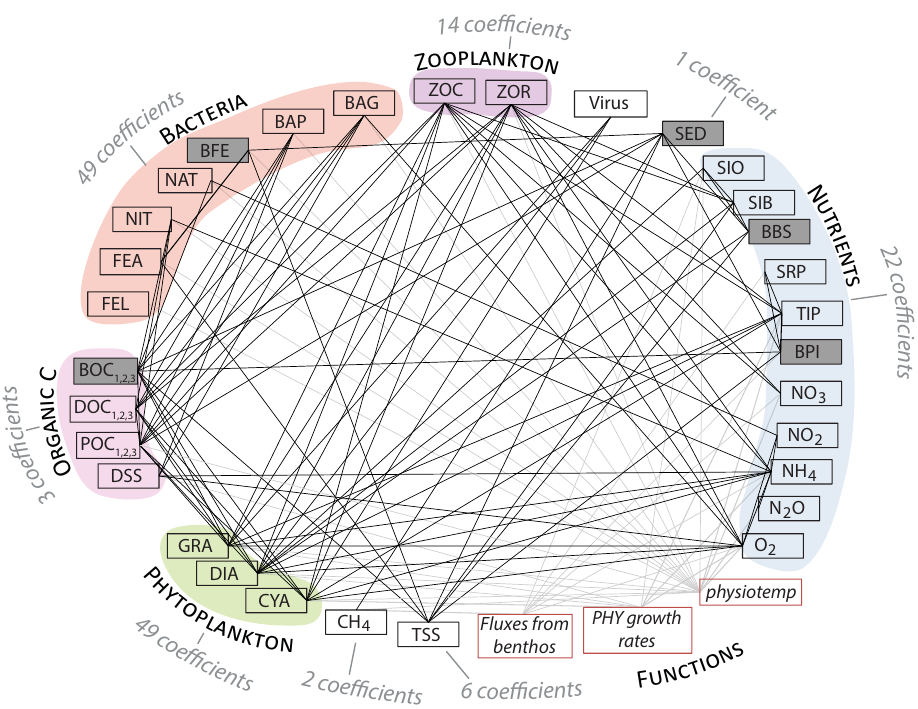
Figure 3. Main variables interdependency in the biogeochemical model Rive and associated coefficients. Gray plain rectangles identify variables describing the benthos component; red rectangles are generic functions often called within the code. Variables and function names and their extensive definitions can be found in Garnier et al.